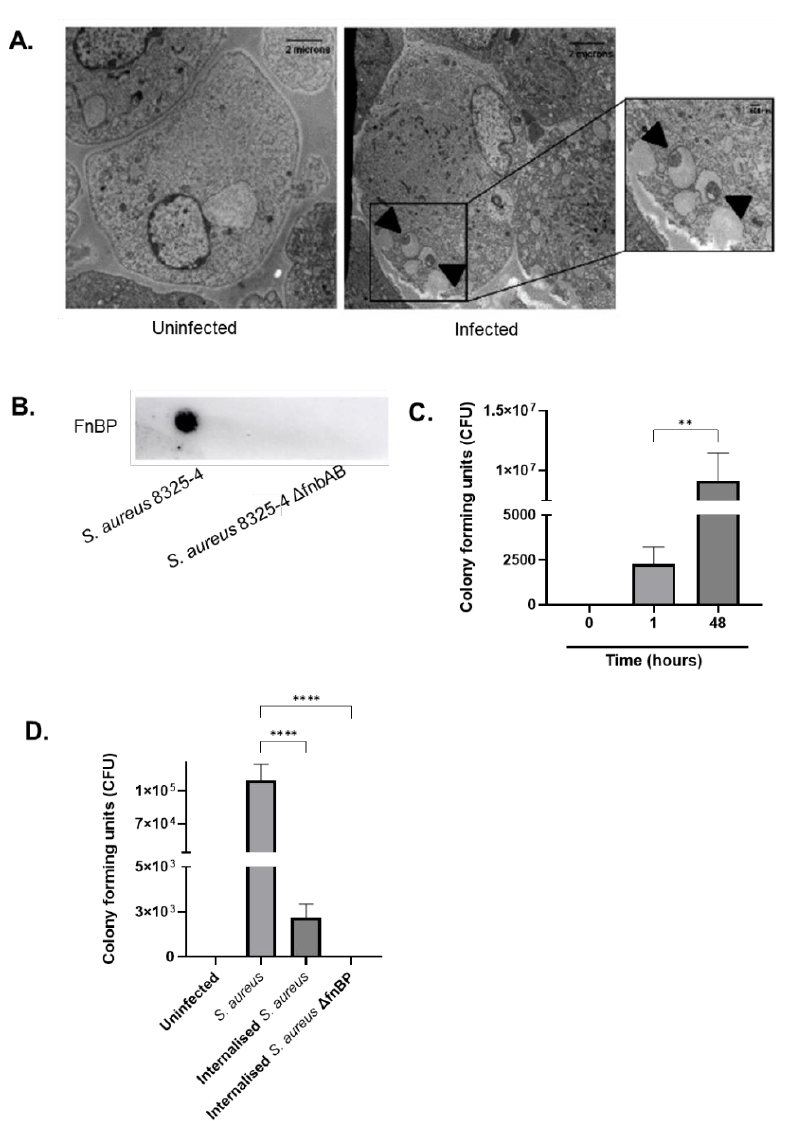
Figure 1. Staphylococcus aureus internalises into endothelial cells via its surface fibronectin binding proteins. ( A ) Transmission electron microscopy images of uninfected and S. aureus 8325-4 infected endothelial cells after 48 h were visualised. The side panel demonstrates the internalisation of S. aureus which localises to membrane vacuoles. Scale bars of uninfected and infected at 2 µm. Scale bars of side panel at 500 nm. ( B ) Dot blot analysis showing FnBP is expressed only in wild-type strain S. aureus 8325-4, and not in FnBP knockout strain S. aureus 8325- 4 ΔfnbAB. ( C ) Endothelial cells were infected with S. aureus 8325-4 over 48 h and intracellular bacteria were quantified as colony forming units, where significant increase in growth was observed ( p < 0.01). ( D ) Primary derived human aortic endothelial cells were infected with the wild-type S. aureus 8325-4 or the mutant S. aureus 8325- 4 ΔfnbAB for 1 h. Cells were lysed and total bacteria (external and internal) were quantified using colony forming units. The experiment was repeating using the gentamycin assay method by treating endothelial cells with 100 µg/mL gentamicin HCl for 1 h. Cells were lysed and bacteria were quantified similarly. Wild-type S. aureus significantly internalised ( p < 0.0001), yet the strain lacking the fibronectin binding proteins was unable to internalise into the endothelial cells. Results are the mean values ± SEM of three independent experiments using 1-way ANOVA followed by Tukey’s post hoc tests. p < 0.05 indicates statistical significance. ** p < 0.01, **** p <